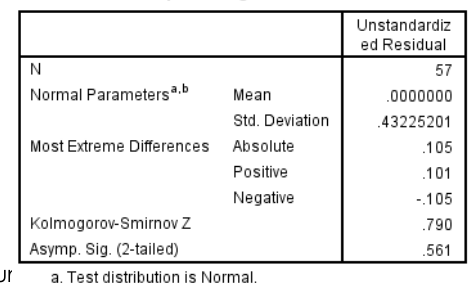
Sumber : Pengolaha Data SPSS